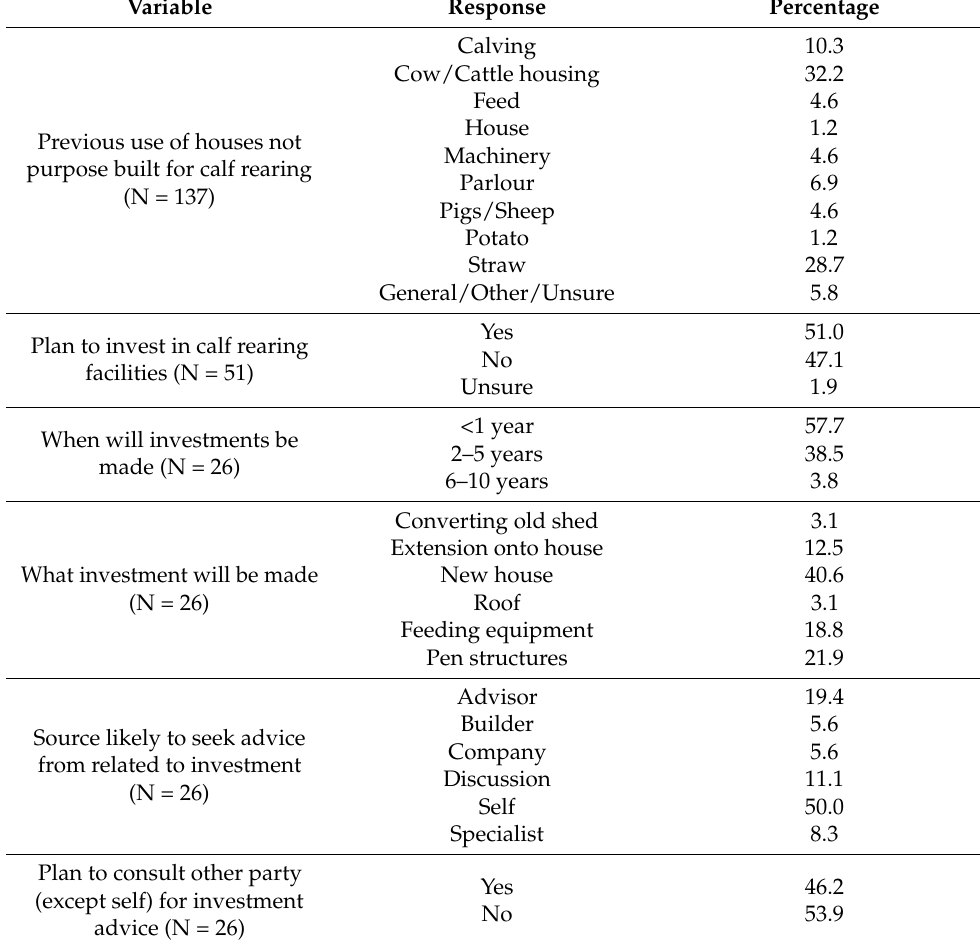
Table 3. Summary of house structures, modifications, and investments of surveyed farms (N =